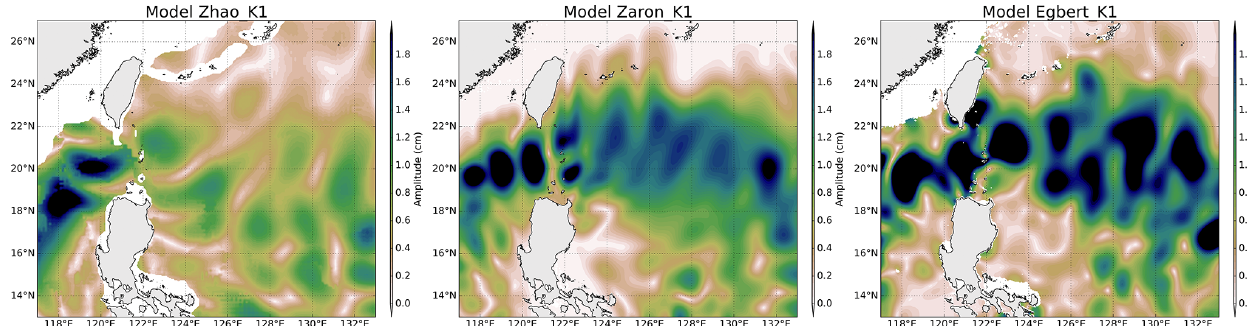
Figure 4. Amplitude of the IT models for the K 1 tide component, in the Luzon area.